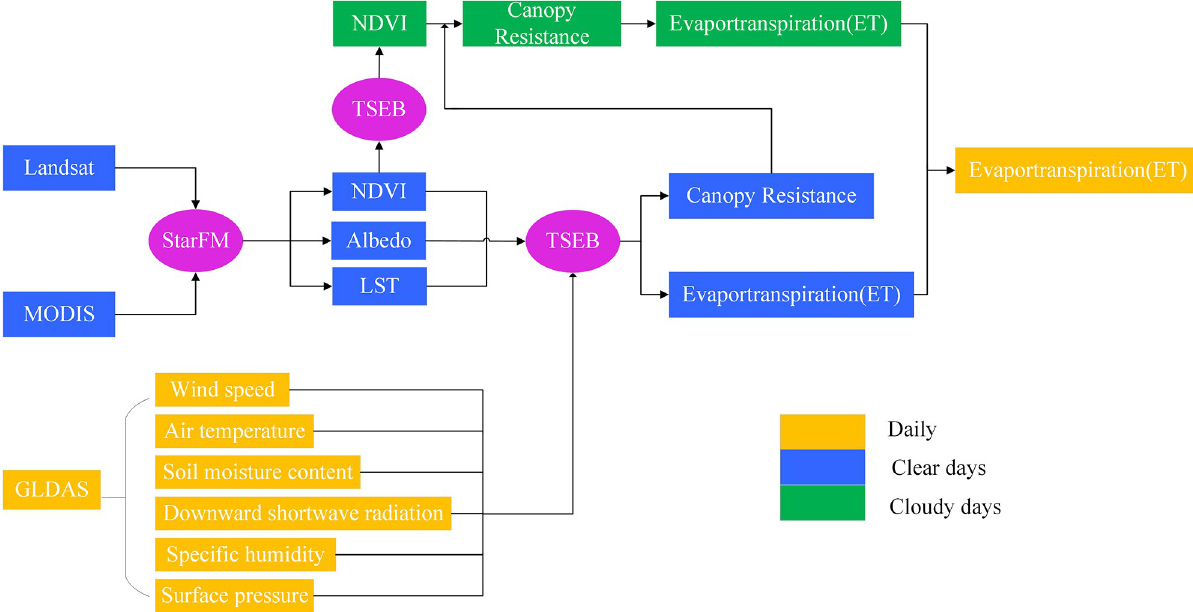
Fig 2. Flow chart of estimating high temporal (daily) and Landsat-like spatial resolution (30 m) ET using the TSEB model with Landsat 5 and MODIS data.